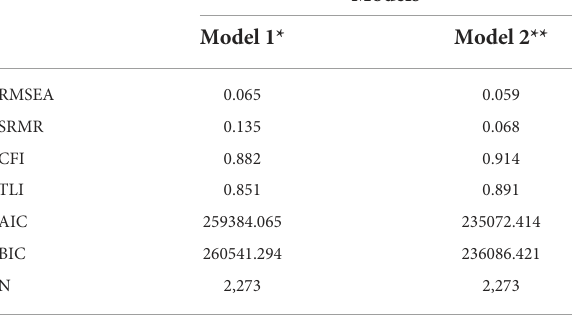
TABLE 11 Statistics resulting from the